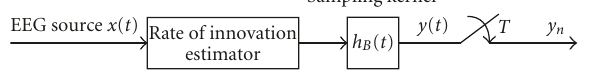
Figure 4: Our proposed scheme for sampling EEG signals with finite rate of innovation.